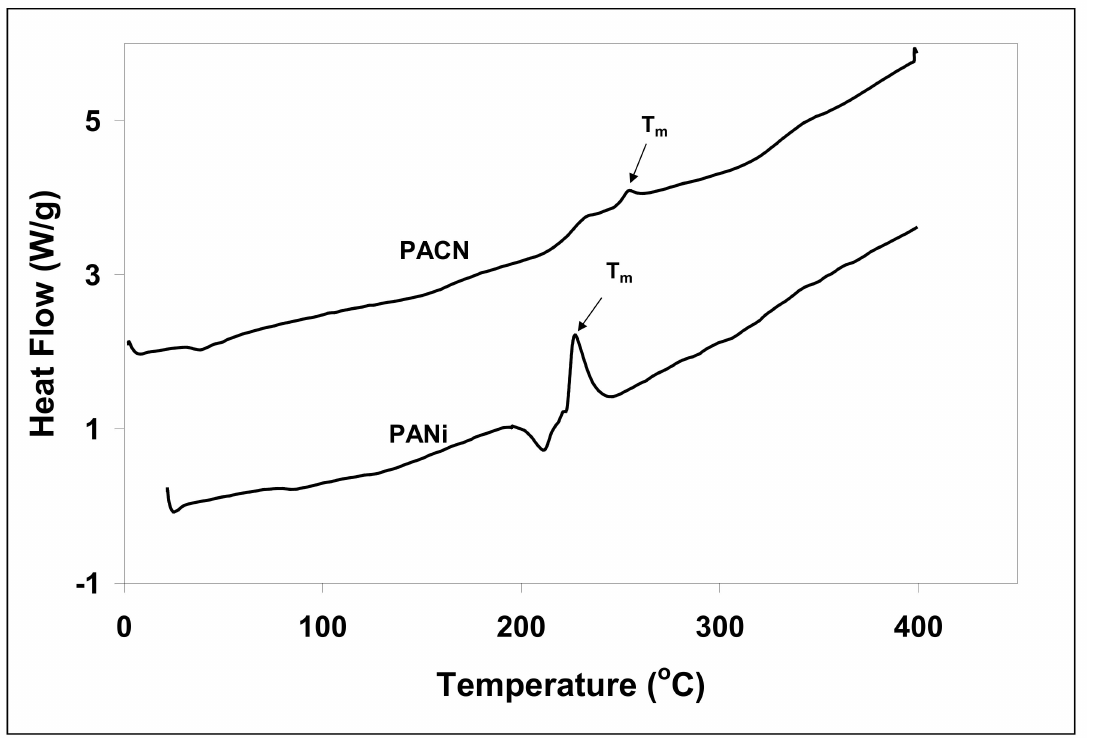
Figure 19. DSC thermograms of PANi and PACN synthesized by using the same oxidant conce-tration of 0.5